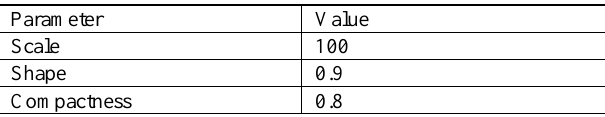
Table 1. Multi-resolution Image Segmentation Parameters used to segment UAS images.